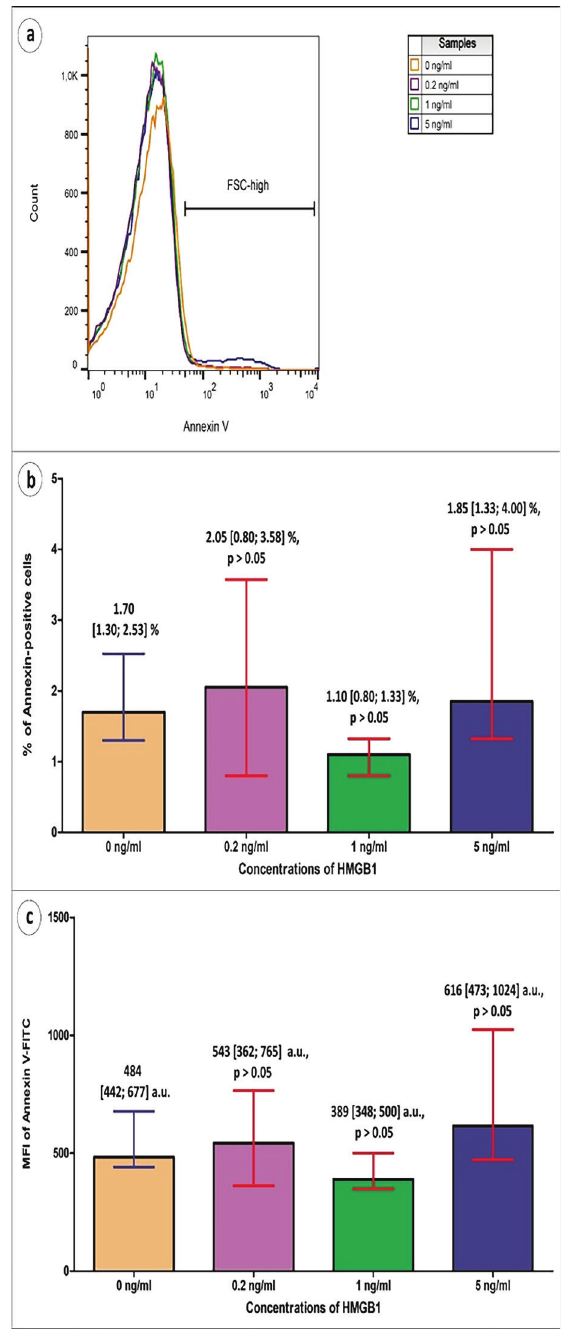
Figure 2 - Phosphatidylserine externalization in erythrocytes exposed to HMGB1 (0-0.2-1-5 ng per ml) for 24 h. Representative side scatter (SSC)/FL1 histograms are shown (panel a). Phosphatidylserine externalization was assessed quantitatively by comparing the percentage of Annexin V-positive cells (panel b) and the mean fluorescence intensity (MFI) values of Annexin V-FITC (panel c). Both eryptosis indices differed statistically insignificantly.